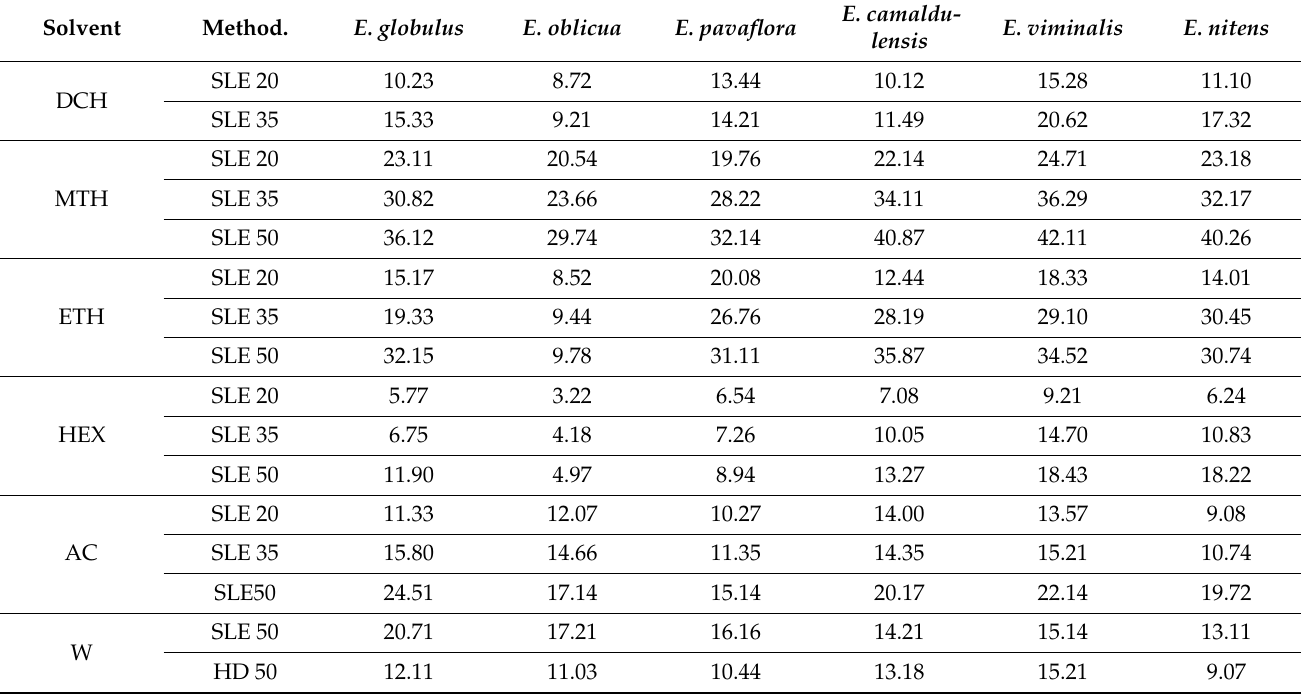
Figure 2. Extraction yields obtained from leaves of six Eucalyptus species mixed with solvents of different polarity, using a Soxhlet extractor. Table 3. Total extraction yield results for SLE and HD methods